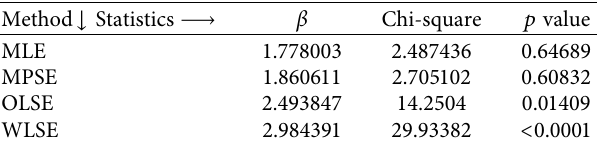
Table 17: Diferent estimators with Chi-square and its p values for data set